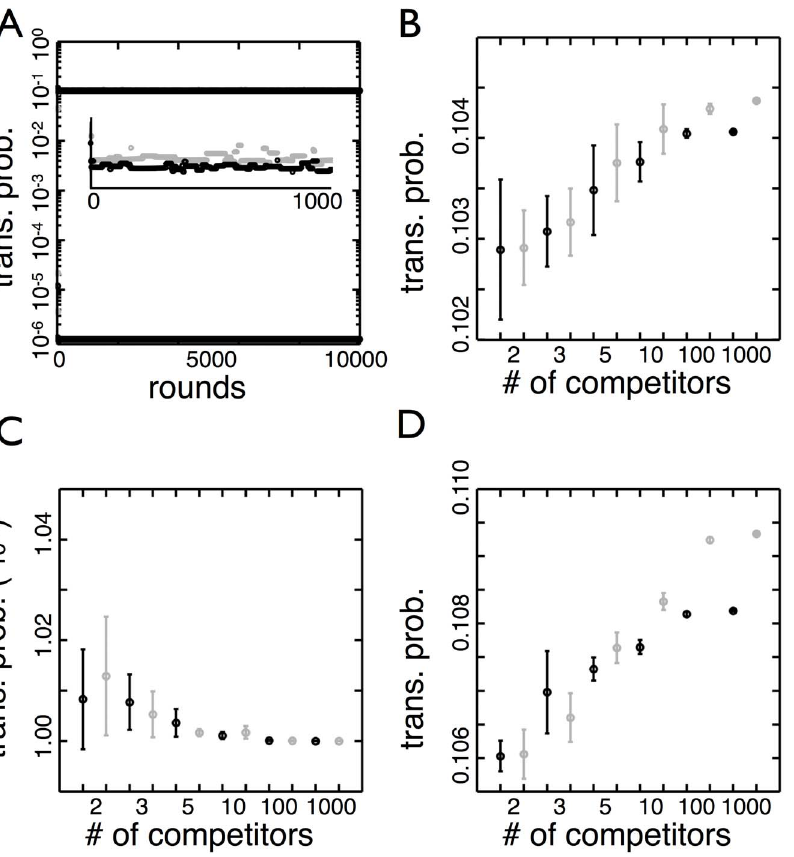
Figure 6. Competition between more than two genotypes. (A) The transition probabilities of the winning genotype are shown over 10,000 environmental cycles ( E S to E W to E S ). Each cycle begins with 1,000 genotypes in equal number and at the end of a full cycle the most abundant genotype (the winner) advances to the next round to compete against new, randomly generated genotypes. The transition probabilities of the winner are grouped by environmental state: black is p s and p w in E S and gray is p s and p w in E W . The inset is a magnification that shows the winner changes frequently but in the long run the winner appears as unbroken lines. (B) The transition probabilities ( p w in E S is black and p s in E W is gray) of the winning genotypes are shown as a function of the numbers of competitors. Each point is the average of 10 runs of tournaments (as shown in A) sampled every 100 rounds after 2500 rounds (‘‘burn-in phase’’). The error bars are the standard deviation of the 10 runs. The values remain close to 10 { 1 for different numbers of competitors. (C) The same as B but this shows the other two transition probabilities ( p s in E S is black and p w in E W is gray) for winning genotypes. The values are all close to the lower bound of transition probabilities considered ( 10 { 6 ), so the number of competitors has no effect. (D) The transition probabilities of the winning genotype are shown when the probabilities do not depend on the environmental state. Due to the symmetry of the system the optimal p s (gray) and p w (black) are identical. There is a statistically significant increase in the transition probabilities for the competition of 1000 competitors versus 2, but the magnitude of difference is